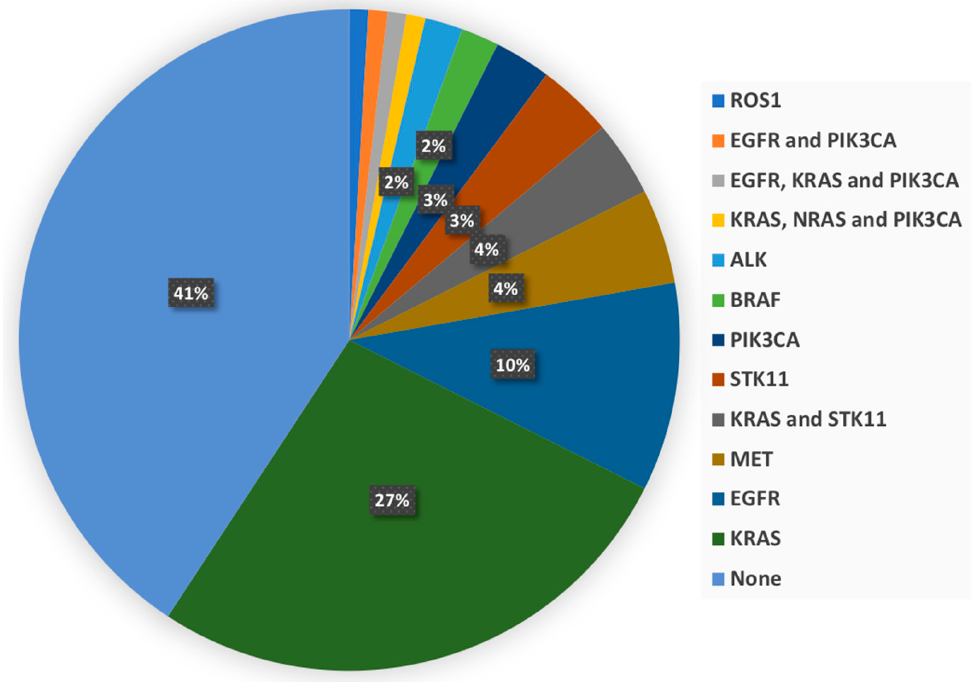
Figure 1. Molecular alterations description of patients. Table 1. Molecular and clinical characteristics of patients.